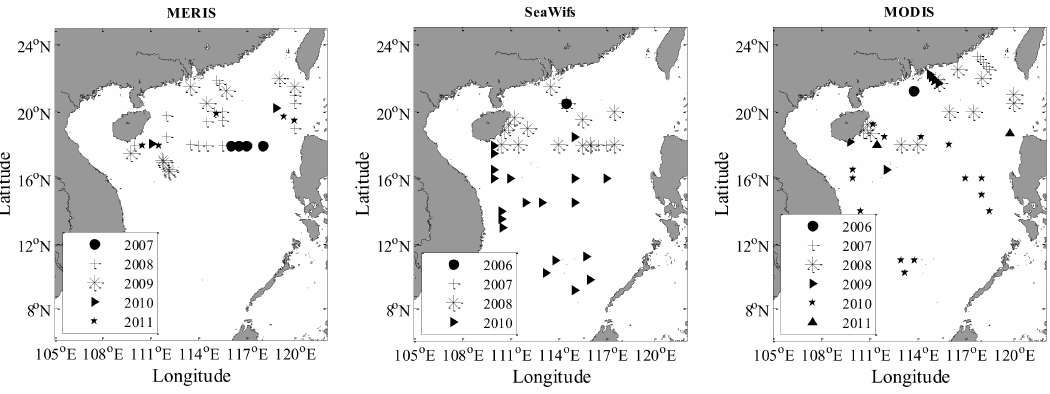
Figure 2. Maps of the matching HPLC data sets for MERIS, MODIS, and